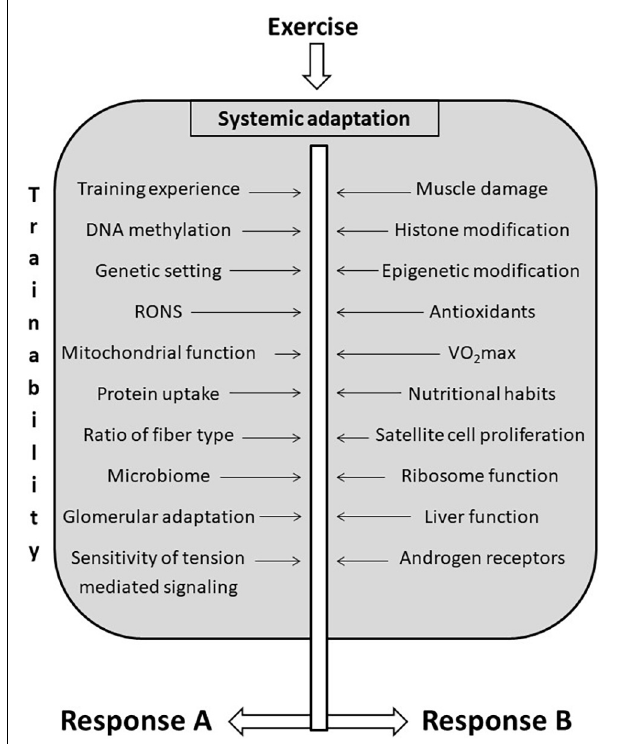
FIGURE 3 | Factors that influencing trainability. There are a great number of factors that influence trainability of different organs. Exercise-induced adaptation is systemic, and the same training load could cause different adaptive responses in different organs indicated as (A,B) , to different functions, and to different